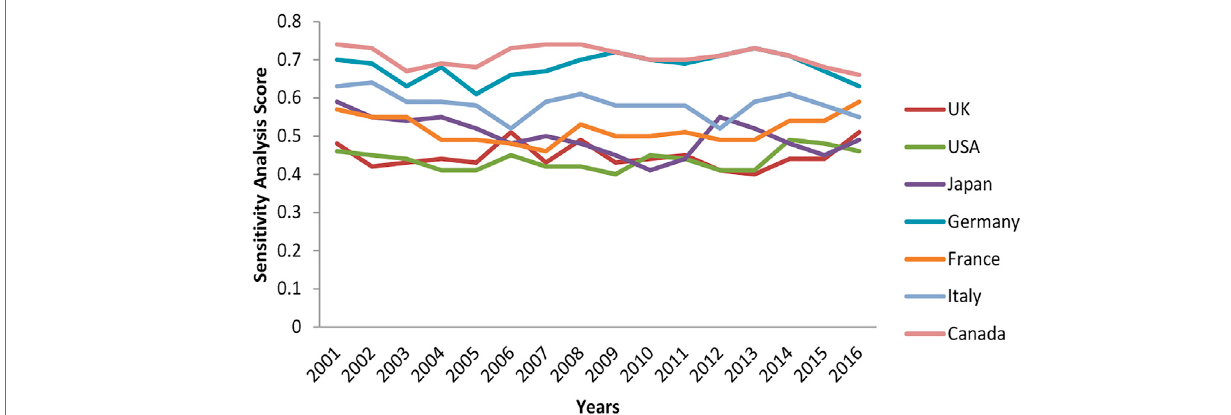
FIGURE 2 | Sensitivity analysis overall EPI score.